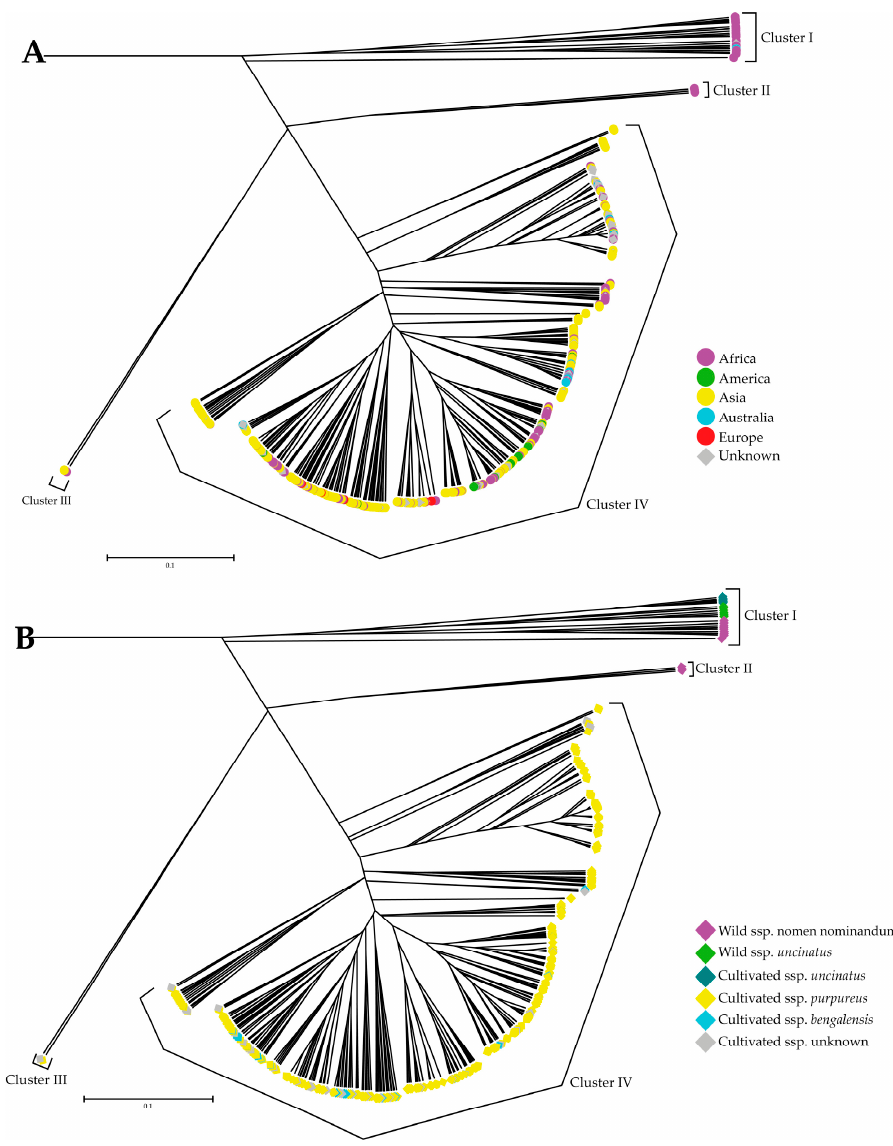
Figure 2. UPGMA tree of 493 lablab accessions based on D A genetic distances [28] The distance was calculated from 15 nuclear SSR markers. ( A ) The accessions are presented based on their geographical origins. ( B ) The accessions are presented based on taxonomical classification.